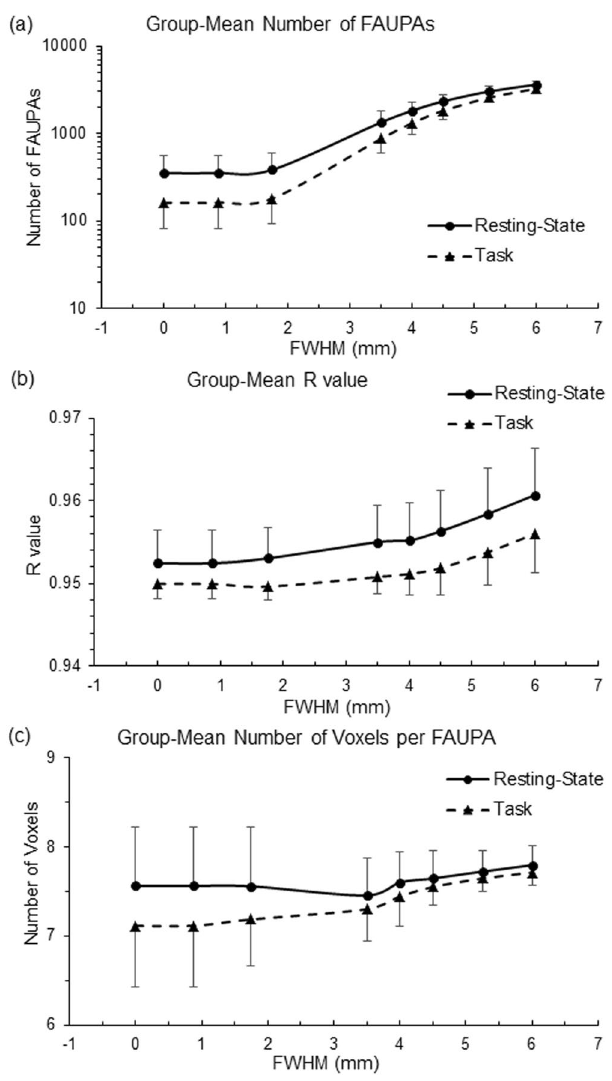
Figure 6. Illustration of the effects of spatial filtering on the detected FAUPAs. ( a ) The group-mean total number of FAUPAs as a function of FWHM; ( b ) The group-mean R values as a function of FWHM; and ( c ) The group-mean number of voxels per FAUPA as a function of FWHM. The error bars indicate the corresponding standard